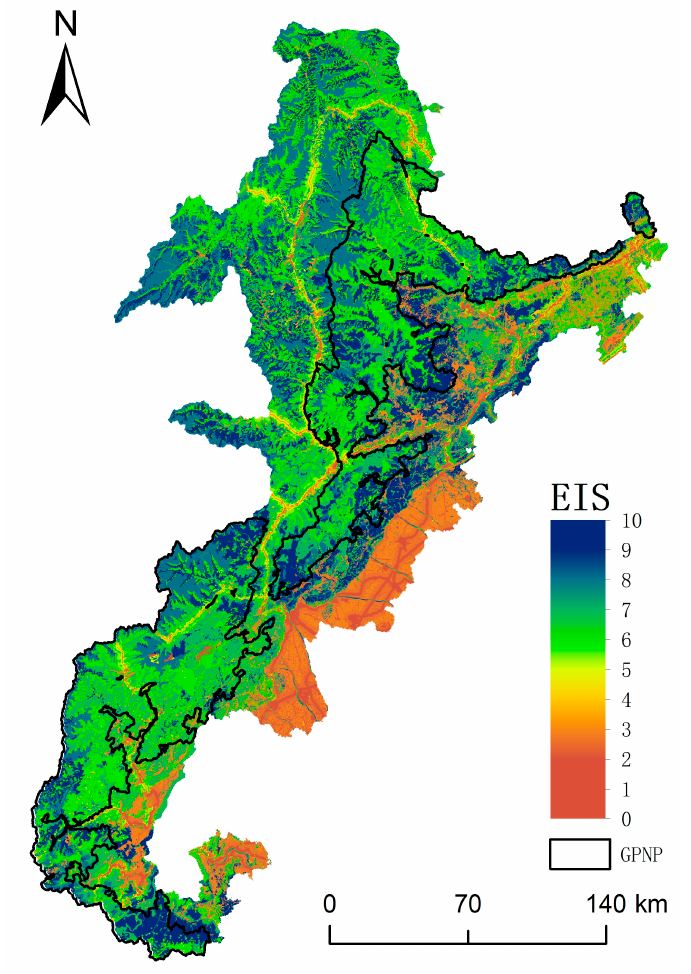
Figure 3. Spatial distribution pattern of different intactness levels in the study area in 2018.